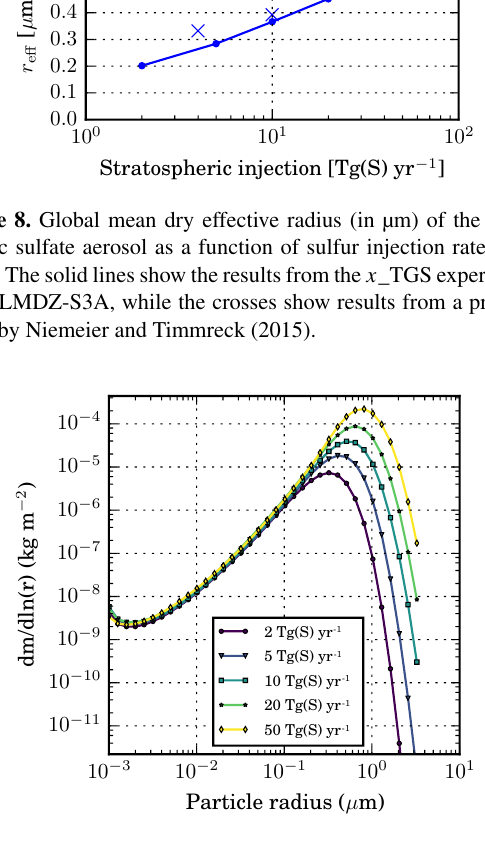
Figure 9. Column-integrated global and annual mean stratospheric aerosol mass size distribution (d m/ dln r , in kg ( H 2 SO 4 ) m − 2 ) for the x _TGS experiments with varying sulfur injection